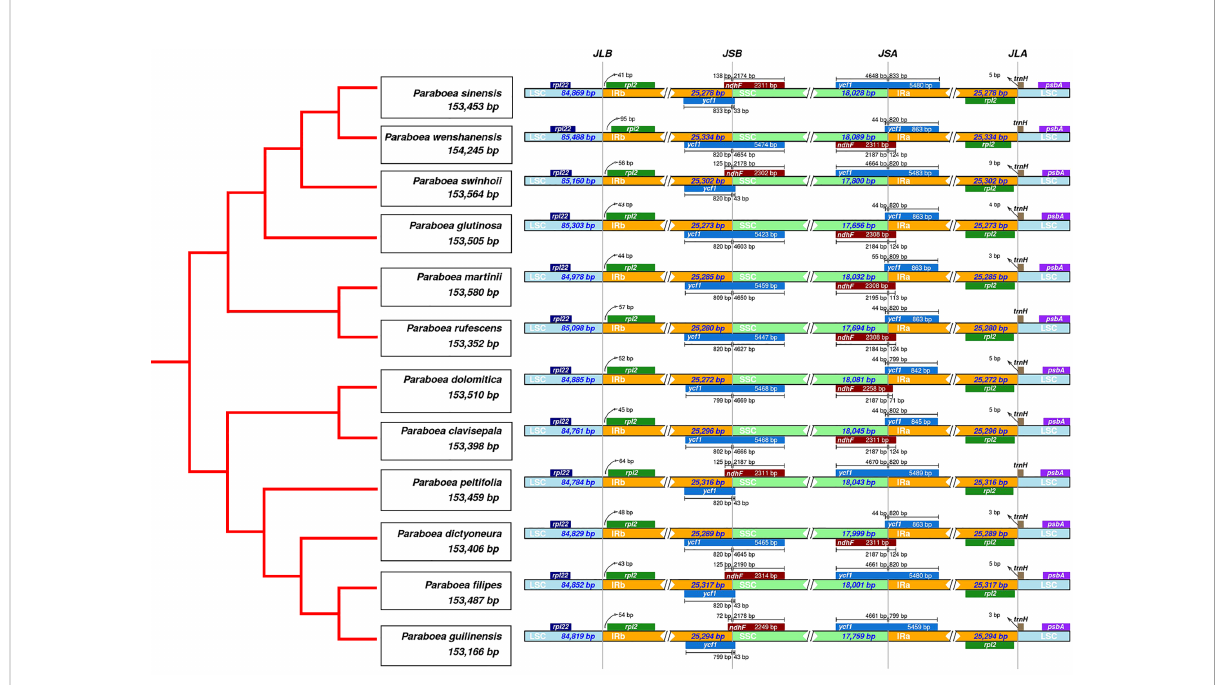
FIGURE 2 Comparison of the borders of the LSC, SSC, and IR regions among twelve chloroplast